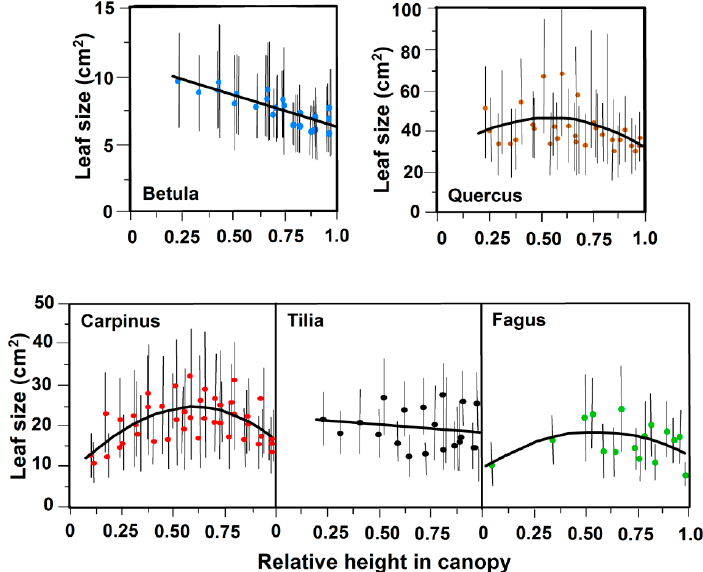
Figure 1. Size of leaf laminas in dependence on height in the canopy of the five tree species. Every point stands for the mean and SD of 125 measurements each taken at a given crown height (different trees from two sites per species). Note different y -axis scaling in the graphs. Table 4. Parameters a, b, and c of exponential regression equations of the form y = a + b x c for the dependence of leaf mass area (LMA) on relative height in the crown for the five species. Correlation